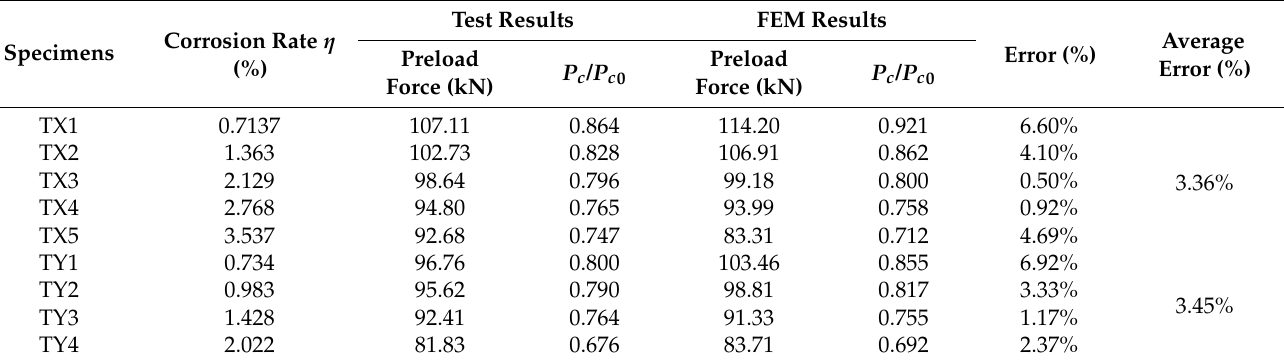
Table 7. Comparison of PF-HSB after corrosion between test and